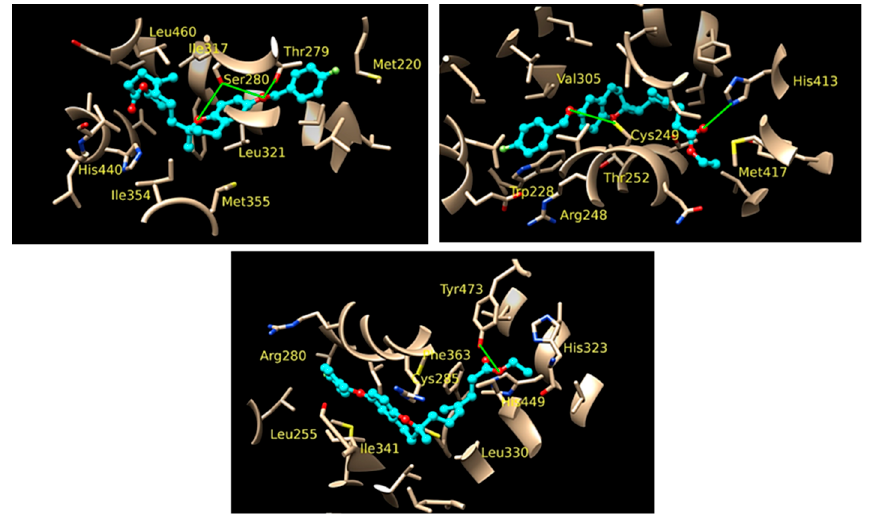
Figure 6. Molecular docking on PPAR α , β , γ receptors of BP-2.